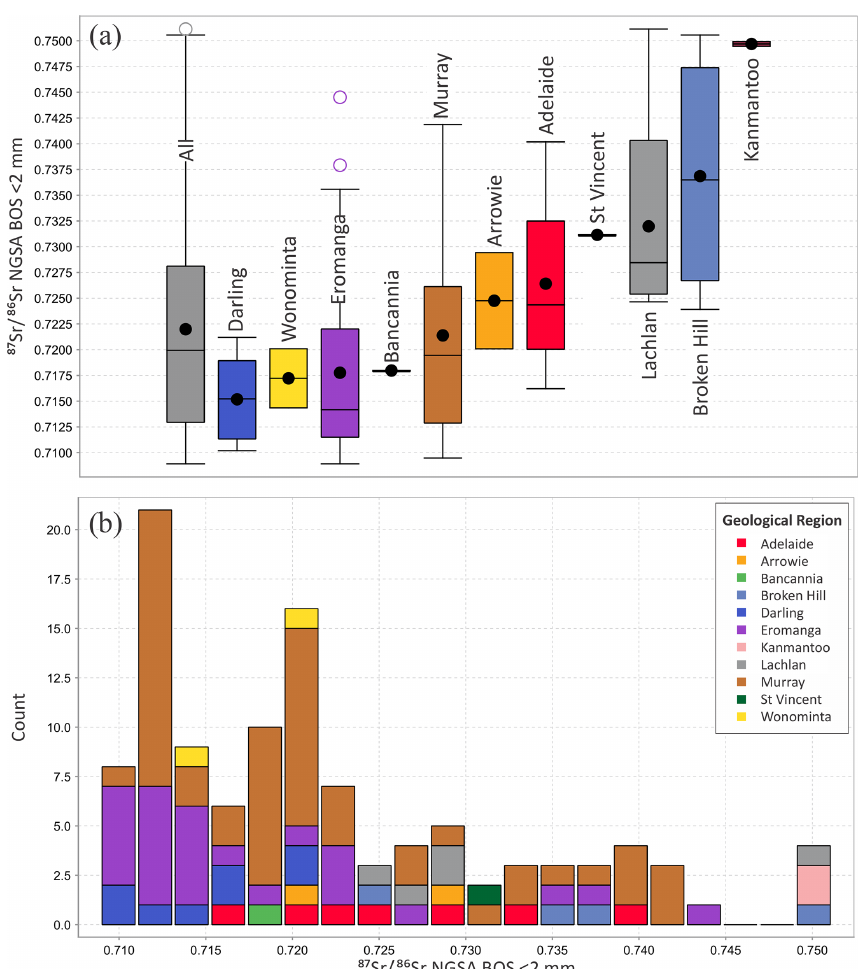
Figure 7. Univariate distribution representations of the 87 Sr / 86 Sr data from the Darling–Curnamona–Delamerian (DCD) Sr isotope study area by geological region: (a) Tukey boxplots of, left to right, the whole dataset first (grey; n = 112), then sorted by increasing median (Darling, n = 8; Wonominta, n = 2; Eromanga, n = 26; Bancannia, n = 1; Murray, n = 54; Arrowie, n = 2; Adelaide, n = 7; St Vincent, n = 1; Lachlan, n = 5; Broken Hill, n = 4; and Kanmantoo, n = 2, geological regions); and (b) histogram by the above